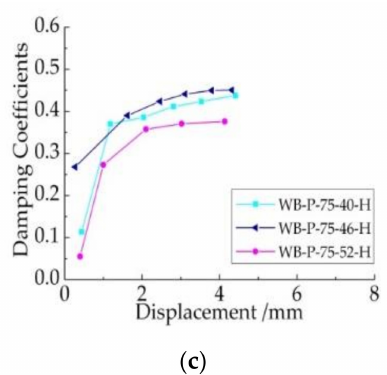
Figure 12. Relation curves between equivalent viscous damping (EVD) ratio and displacement for specimens in groups ( a ) TC, ( b ) WA and ( c )